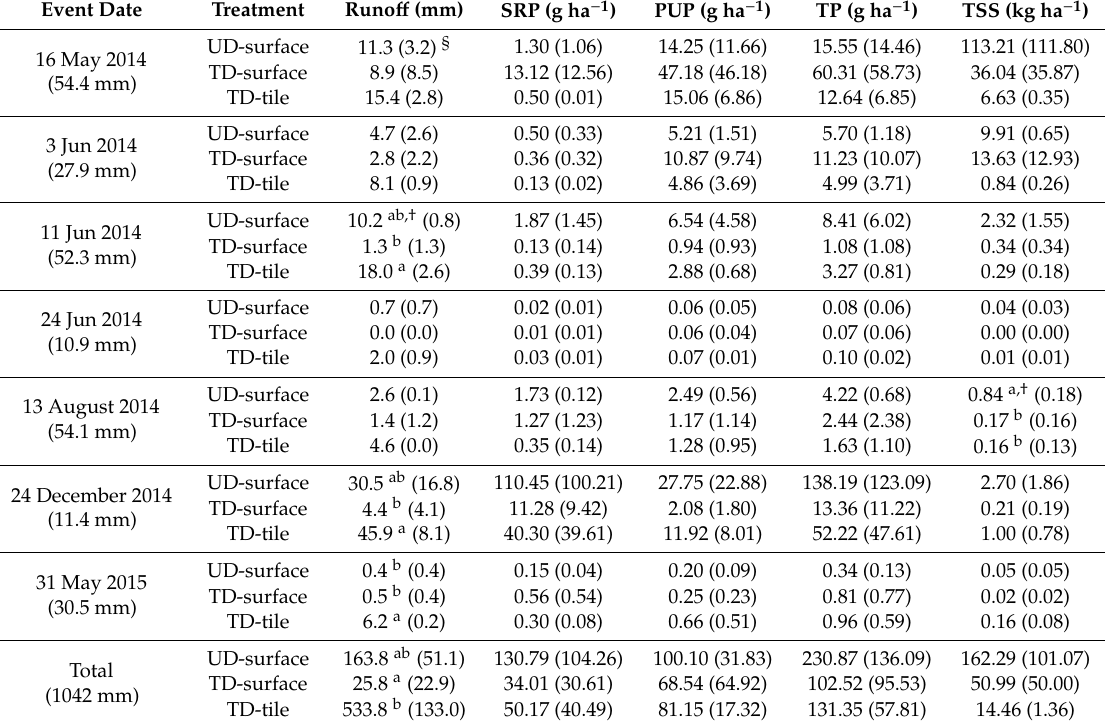
Table 2. Mean runo ff , soluble reactive phosphorus (SRP), particulate / unreactive phosphorus (PUP), total phosphorus (TP) and total suspended solids (TSS) export by each runo ff pathway in tile-drained plots (TD) and undrained plots (UD) for all major runo ff events and cumulative export for the study duration. Rainfall (mm) for each event is included in parentheses below the event start